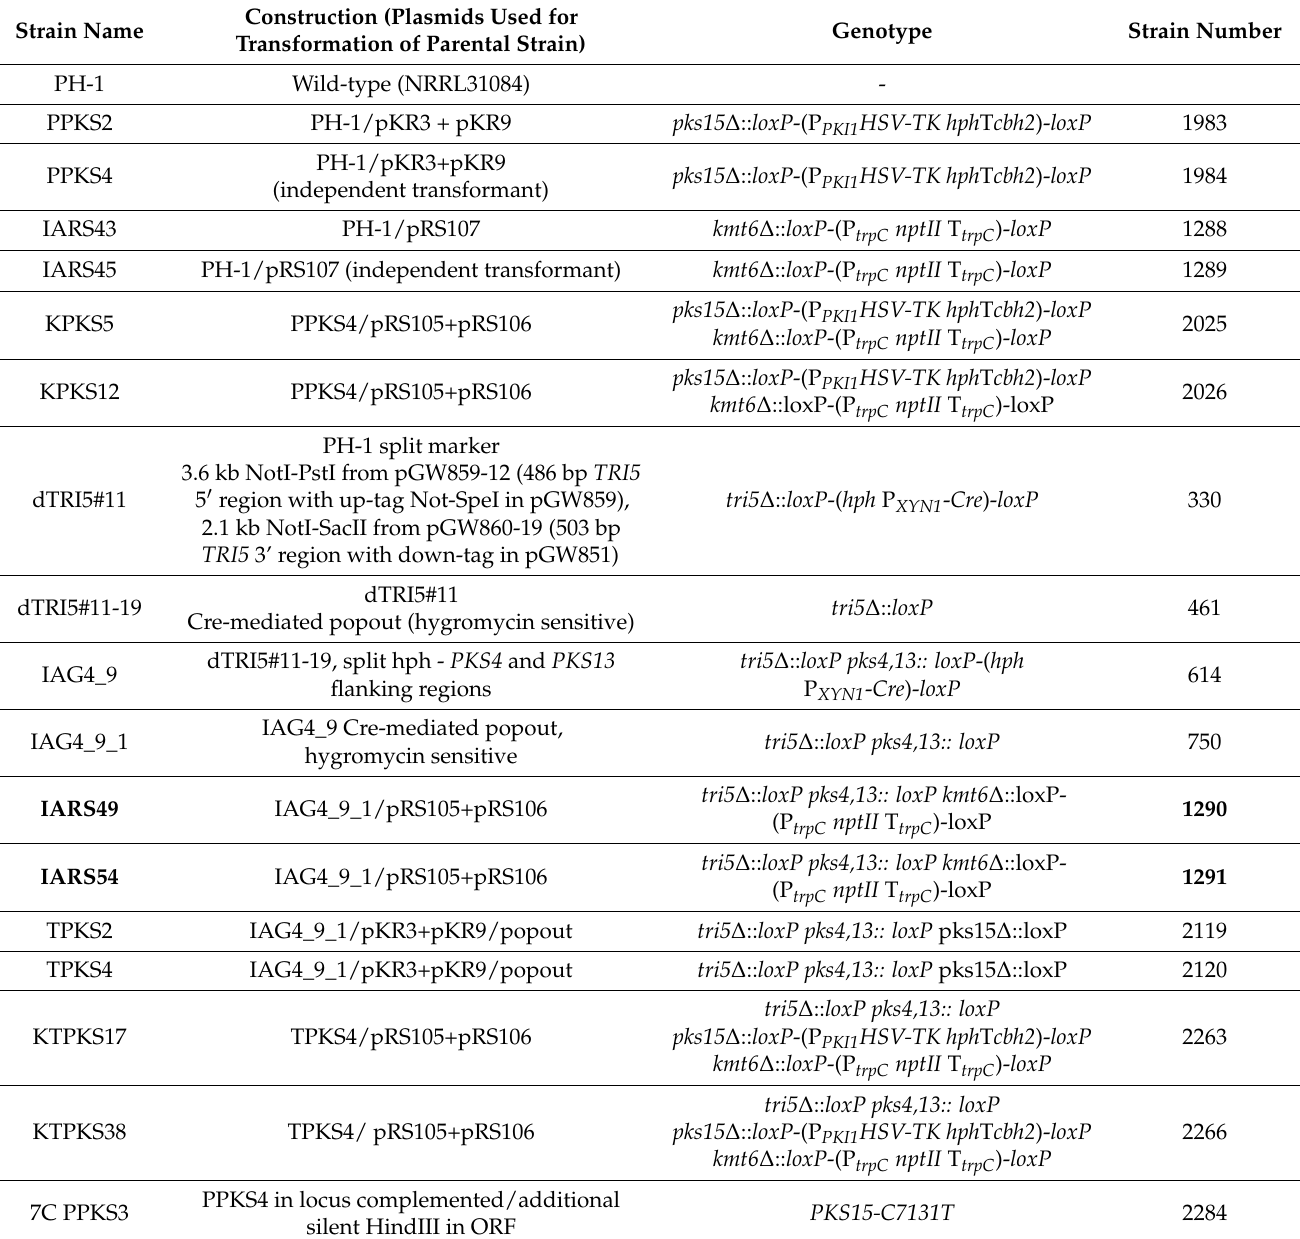
Table 1. Construction and genotypes of Fusarium strains used in this